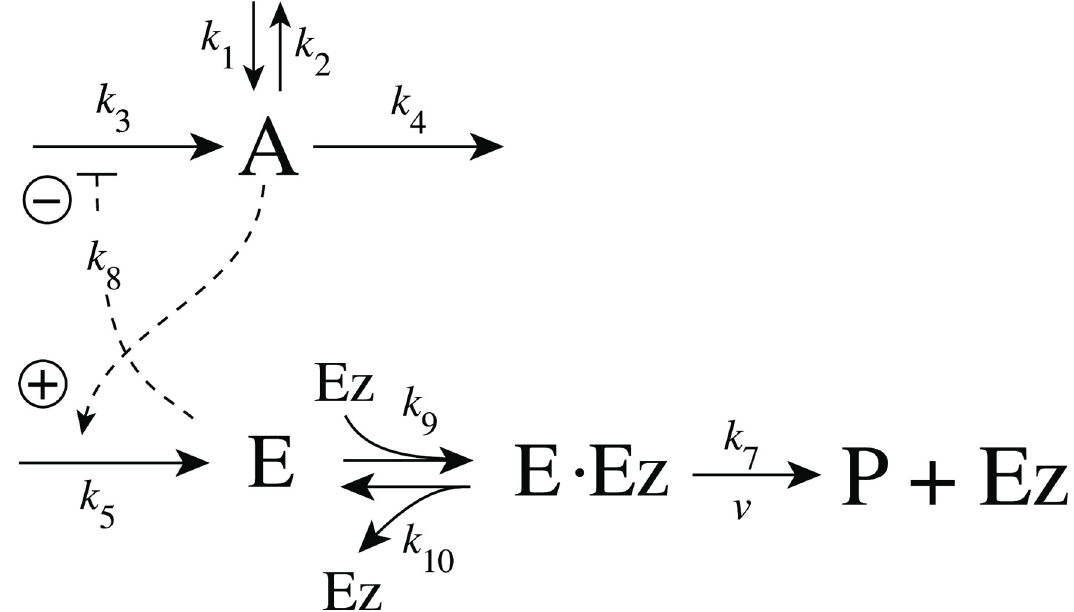
Fig 6. Motif 2 single-E controller: Removal of E by enzyme Ez using a Michaelis-Menten mechanism.